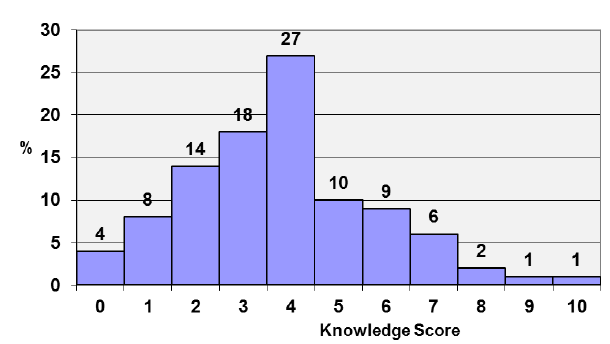
Figure 1: Knowledge score The distribution of the knowledge score was positively skewed (skewness value of 0.353). The Kolmogorov- Smirnov test compares the score in a sample to a normally distributed set of scores with the same mean and standard deviation (Field, 2010). According to Field (2010), if the test is significant (p < 0.05), the distribution is significantly different from a normal distribution (not